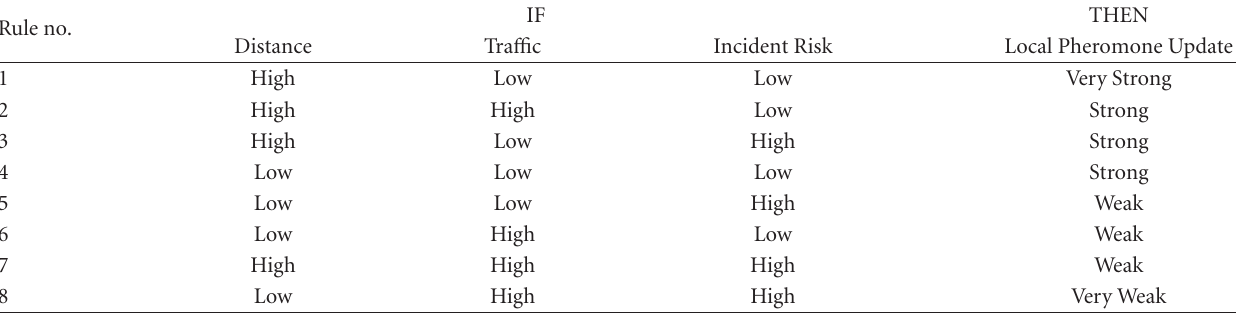
Table 1: The IF-THEN rules set for FLACS